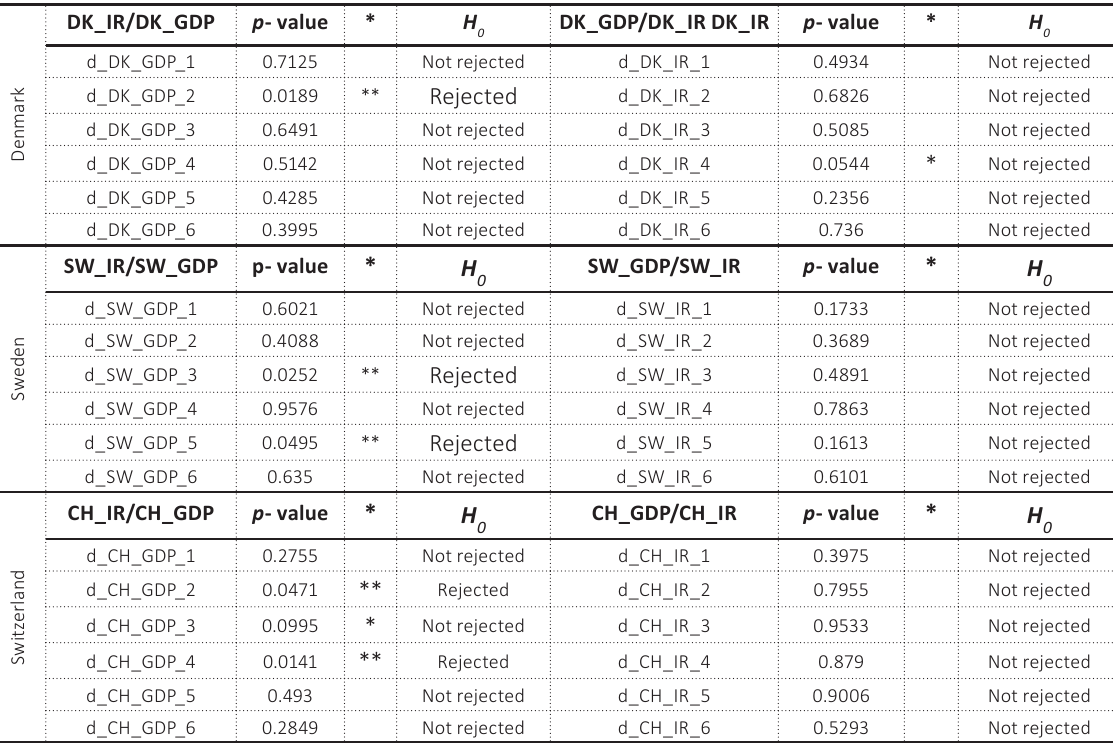
Source: Authors’ own work based on the results of Gretl.